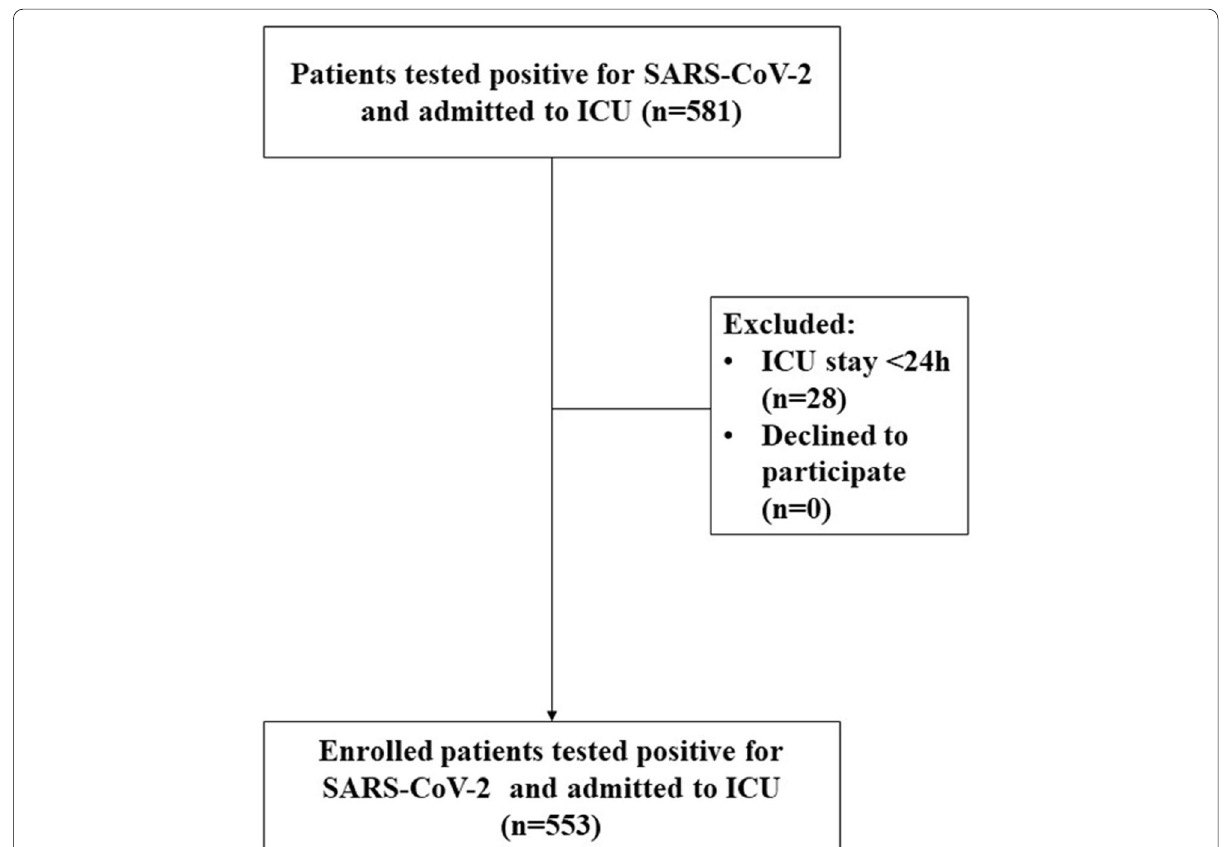
Fig. 1 CONSORT flow diagram summarizing patients eligible for the